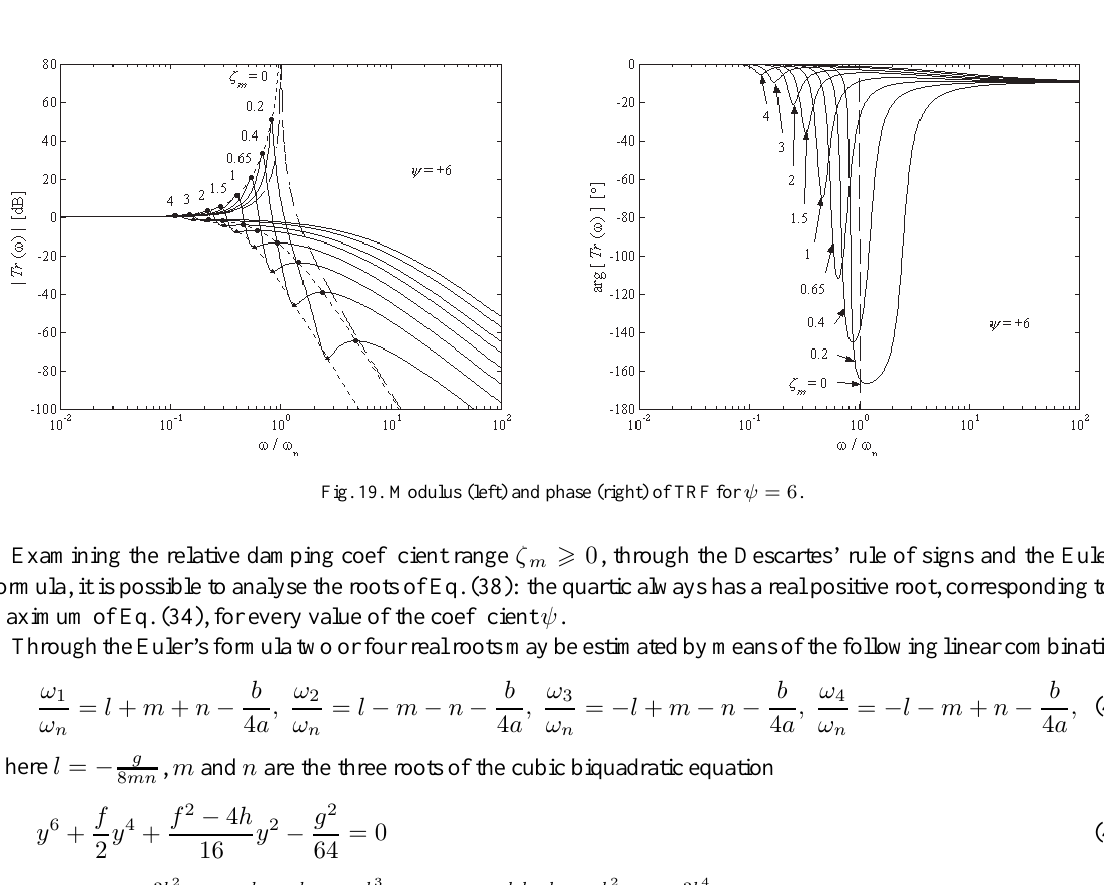
Fig. 18. Modulus (left) and phase (right) of TRF for ψ = 3 . 5 .